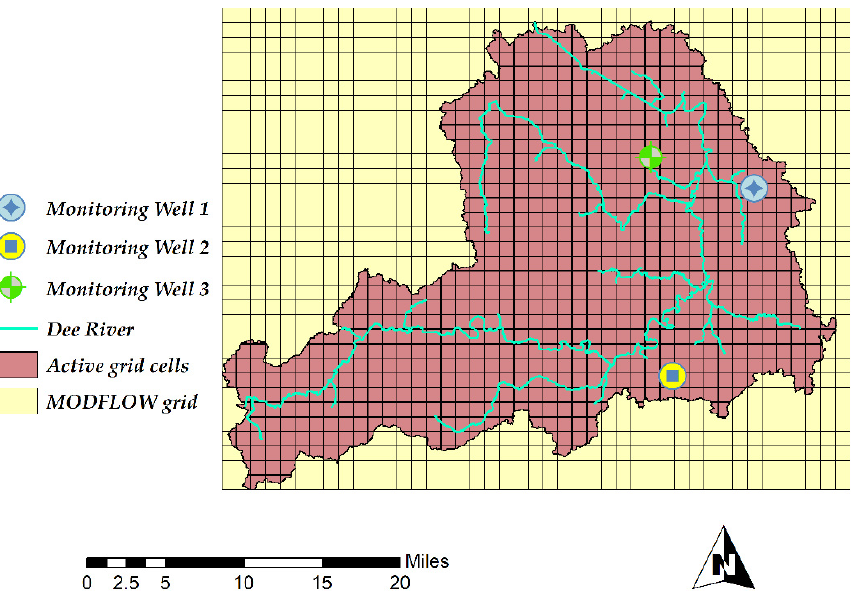
Figure 10. MODFLOW grid with the location of groundwater monitoring wells in the Dee River basin.